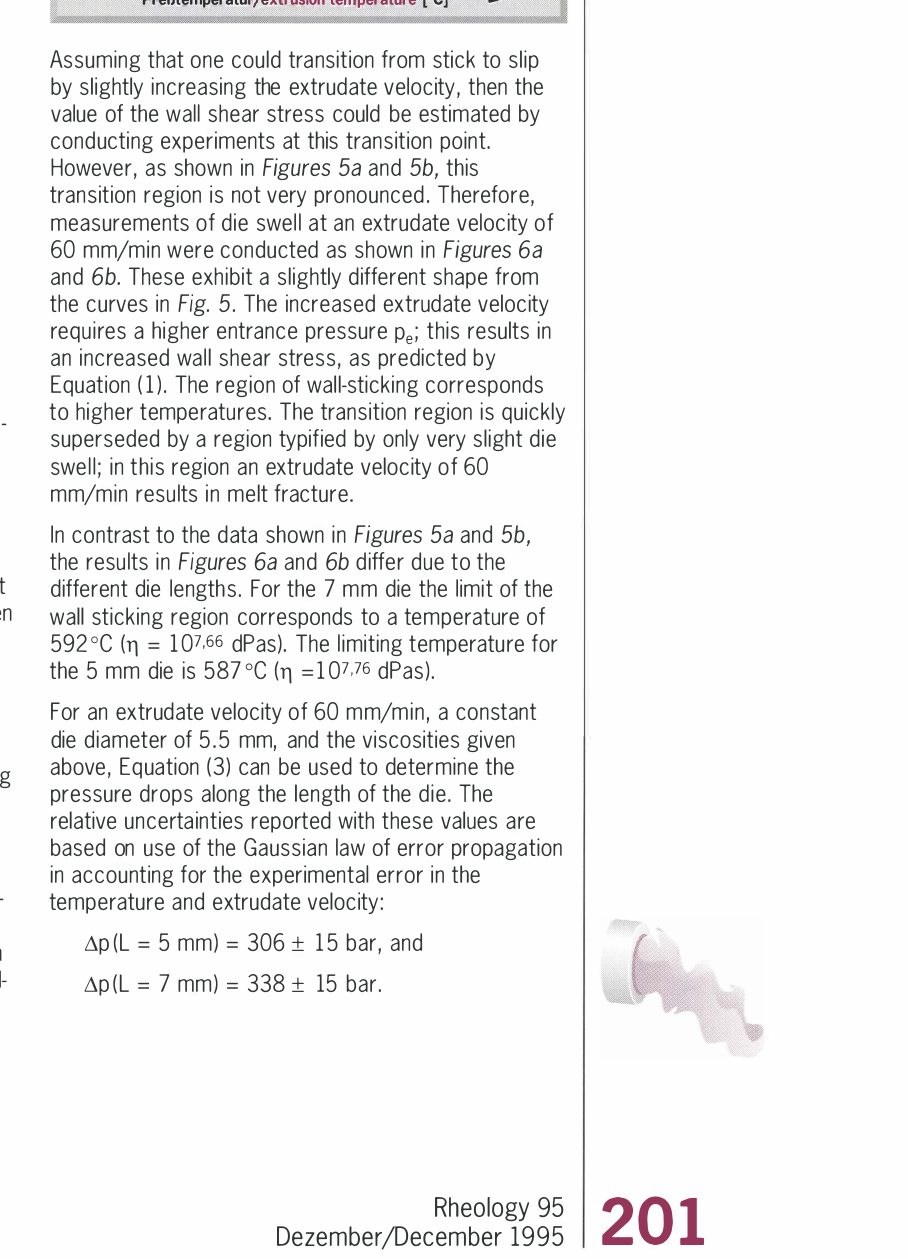
Fig. 6: Die swell aA at an extrudate velocity of 60 mmjmin for (a} 5 mm and (b) 7 mm long dies as a function of extrusion